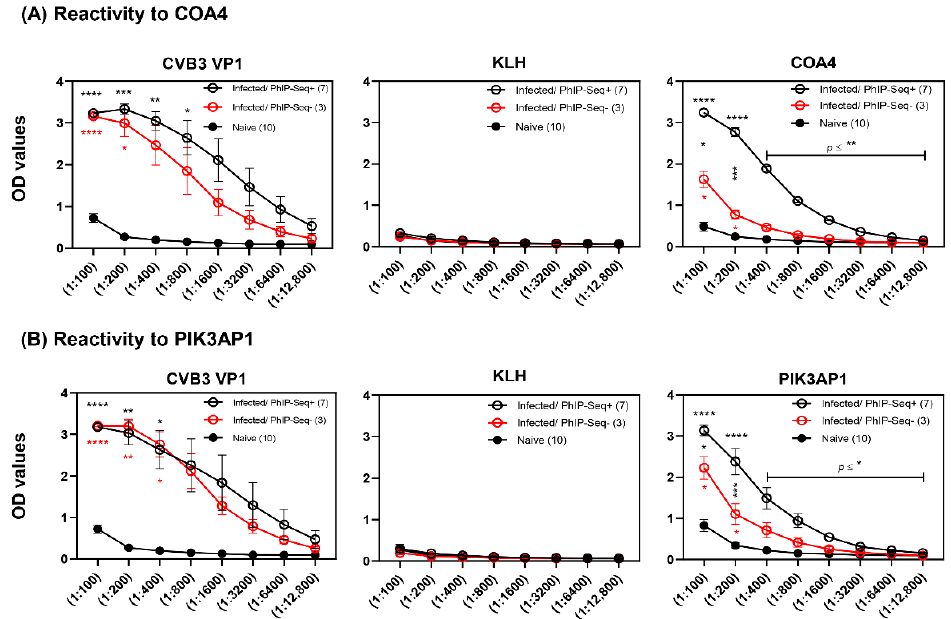
Figure 3. Sera from CVB3-infected mice reveals antibodies to COA4 and PIK3AP1. Sera were collected from A/J mice that were infected with CVB3 ( n = 10) or control groups ( n = 10) on day 21 and evaluated by ELISA for the presence of COA4- and PIK3AP1-reactive antibodies. ( A ) Reactivity to COA4. Sera from infected animals positive (infected/PhIP-Seq + ) or negative (infected/PhIP-Seq - ) for COA4, along with sera from naïve mice, were serially diluted and added in duplicates to plates coated with COA4, CVB3 VP1 (positive control), and KLH (negative control). ( B ) Reactivity to PIK3AP1. Sera from infected animals positive (infected/PhIP-Seq + ) or negative (infected/PhIP-Seq - ) for PIK3AP1, along with sera from naïve mice, were serially diluted and added in duplicates to plates coated with PIK3AP1, CVB3 VP1 (positive control), and KLH (negative control). Sequentially, anti-mouse HRP-conjugated total Ig was added as detection antibody followed by substrate. After stopping the reactions, plates were read at 450 nm to obtain OD values. Mean ± SEM values are shown. Two-way ANOVA with Tukey’s test was used to determine significance between groups. *